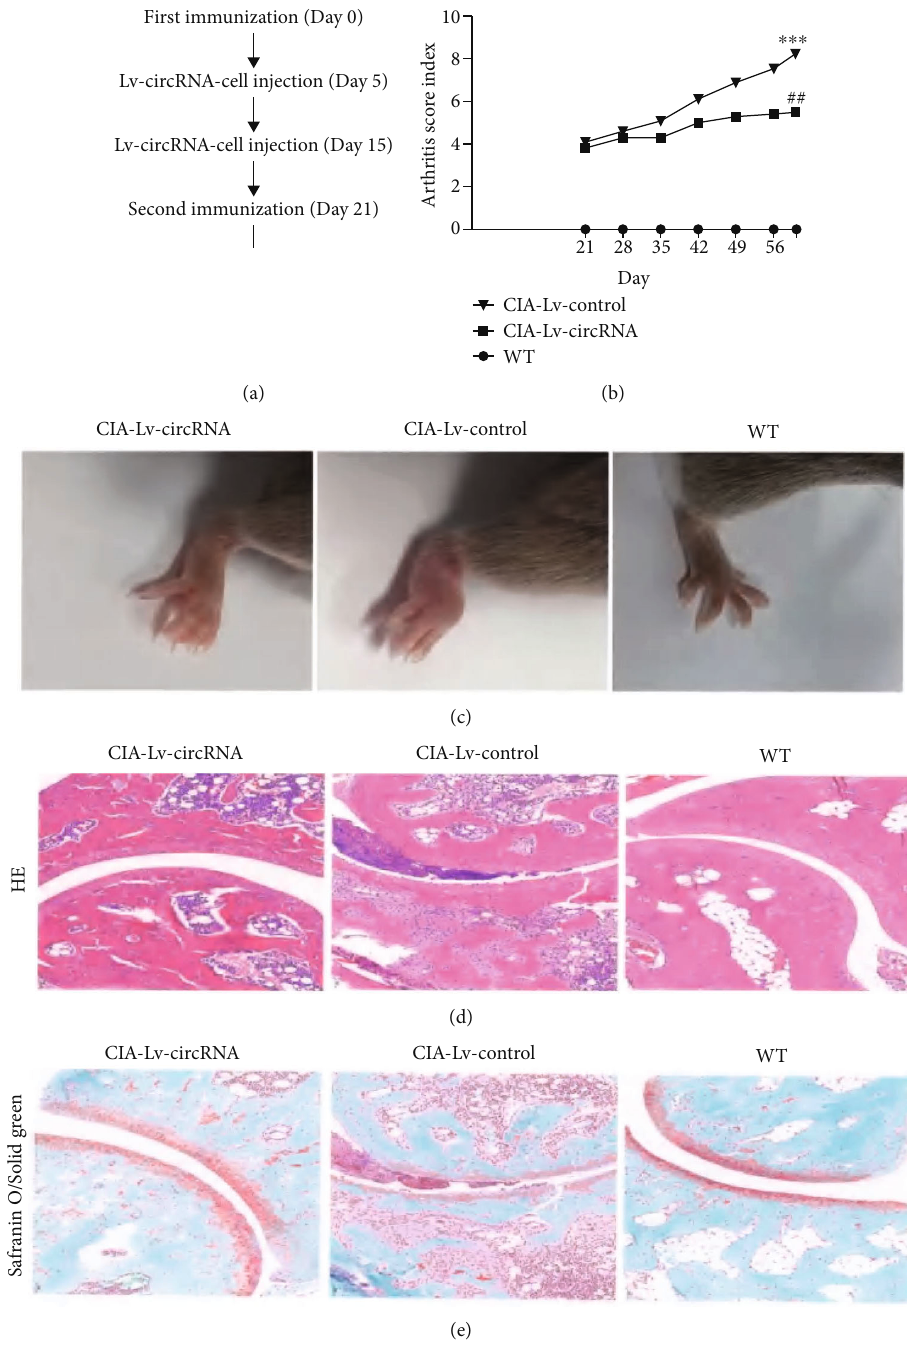
Figure 8: circRNA_17725-overexpressed macrophage alleviated arthritis in CIA mice. (a) CIA mouse model construction fl owchart (6 mice/group). (b) Arthritis score: circRNA_17725-overexpressed macrophage-treated CIA mice had lower arthritis score (vs. the WT group, ∗∗∗ P < 0 : 001 ; vs. the CIA-Lv-control group, ## P < 0 : 01 ). (c) Representative pictures: less redness, swelling, and alleviated arthritis of CIA mice treated by circRNA_17725-overexpressed macrophages. (d) Representative pictures of HE staining of joint tissues from CIA mice treated by circRNA_17725-overexpressed macrophages (20x). (e) Representative Safranin O/Solid green staining pictures: less severe cartilaginous injury and bone damages in the joint tissues of CIA mice treated by Lv-circRNA-transfected macrophages